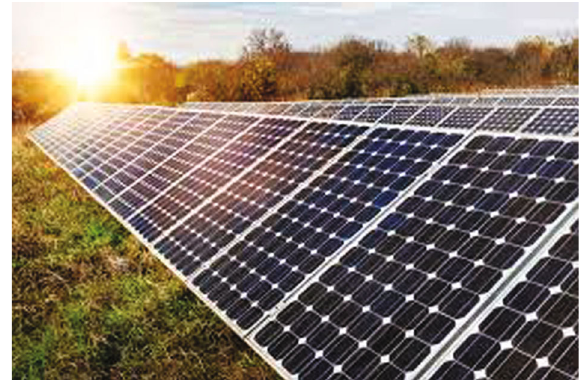
Figure 1: Source of solar energy.